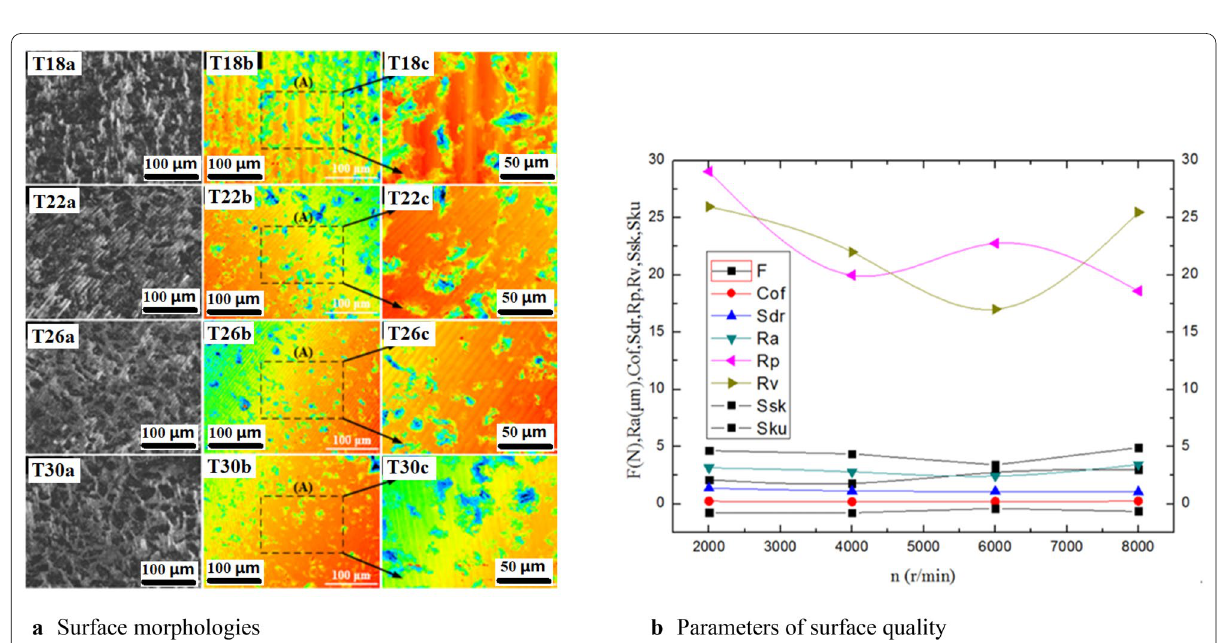
Figure 9 Experimental results of group